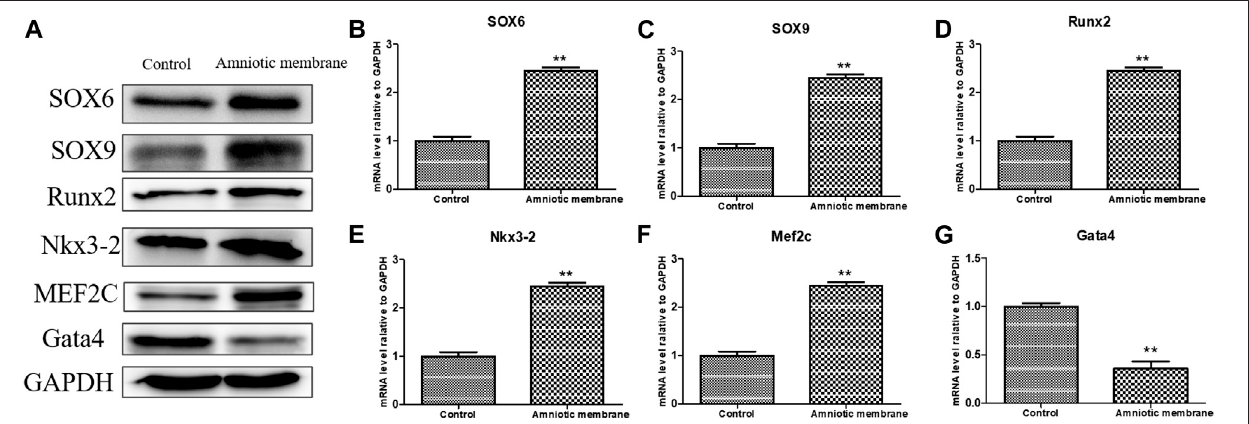
FIGURE9| Theeffectofamnioticmembraneontranscription andtranslationlevelsofRunx2,Aggrecan,Nkx3-2,MEF2C,Gata4,SOX6,andSOX9genes. (A) The expression levels of Runx2, Aggrecan, Nkx3-2, MEF2C, Gata4, SOX6, and SOX9 under amniotic membrane treatment were detected by Western blot. The expression of GAPDH was considered as the loading control. (B – G) The mRNA level of (B) SOX6, (C) SOX9, (D) Runx2, (E) Nkx3-2, (F) MEF2C, and, (G) Gata4 in the control and amniotic membrane treatment group, n (cid:2) 3. ** p < 0.01, * p < 0.05.